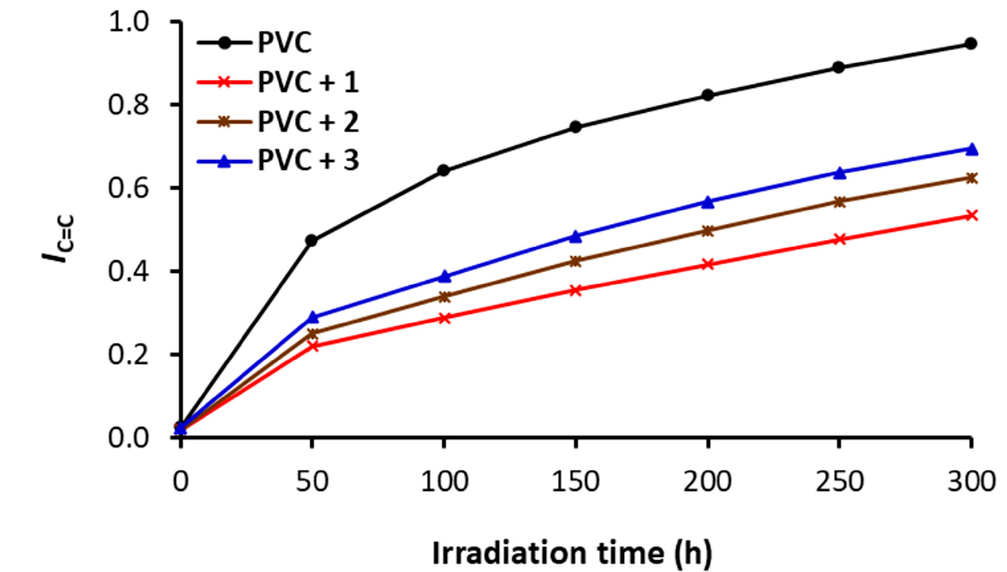
Figure 3. Effect of the time of irradiation on the I C=C of PVC films.